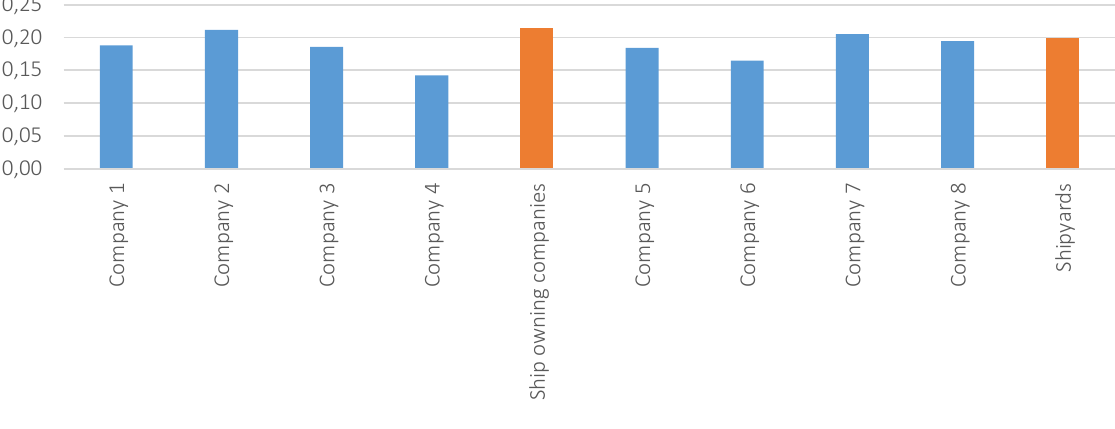
Figure 11. The value of the integral index of the financial state of the shipping companies and shipyards